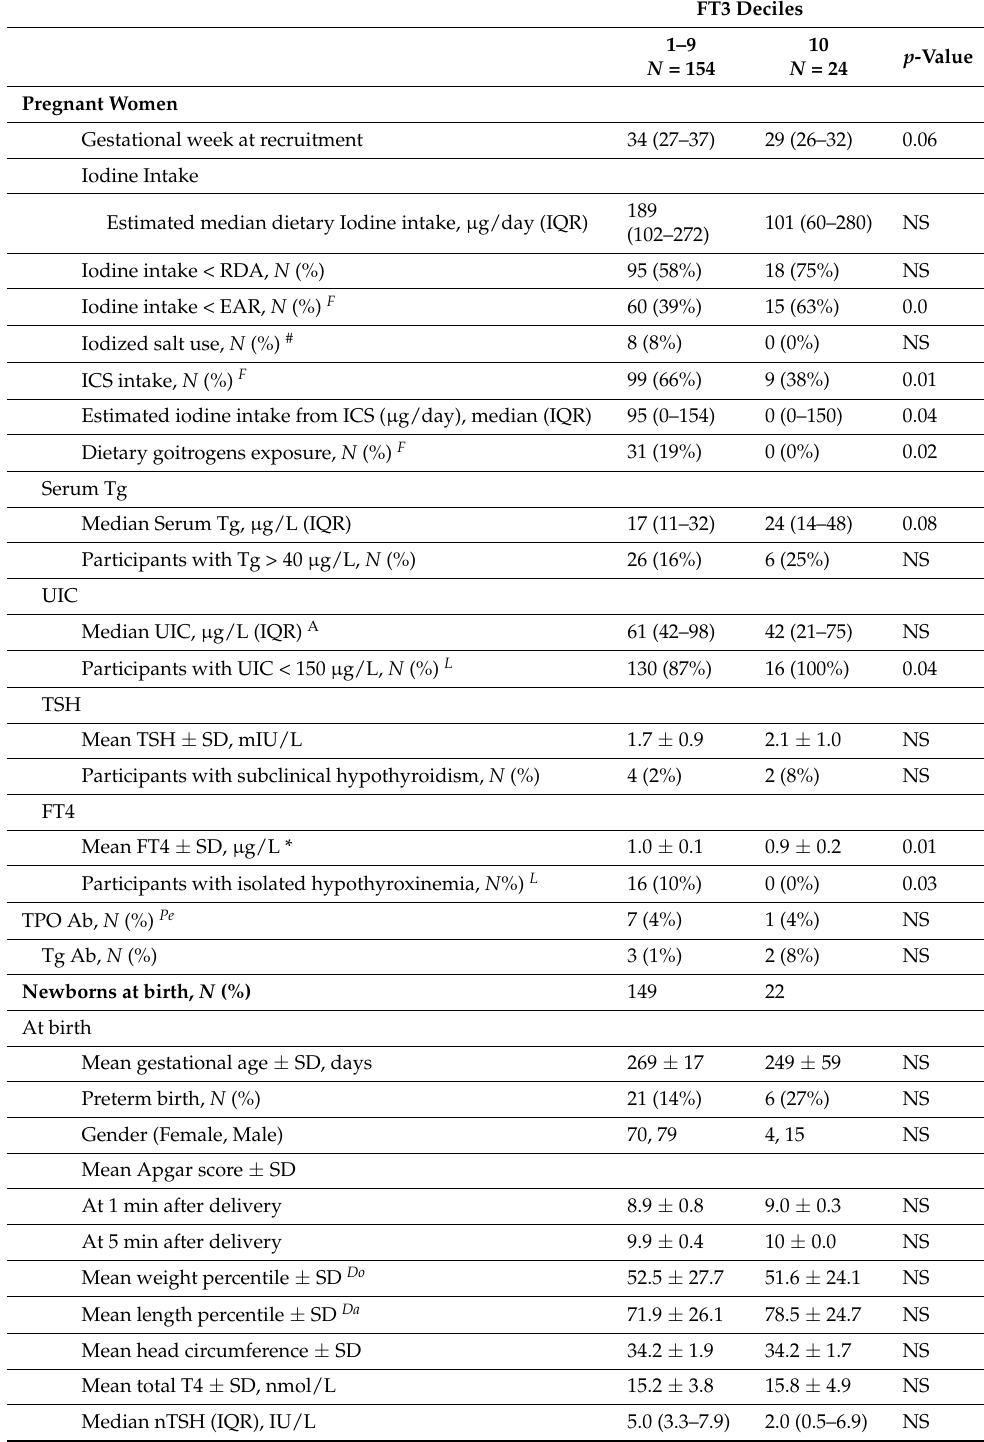
Table 3. Iodine-related dietary characteristics and thyroid function tests d of pregnant women and their newborn pregnancy outcomes and newborn anthropometrics by FT3